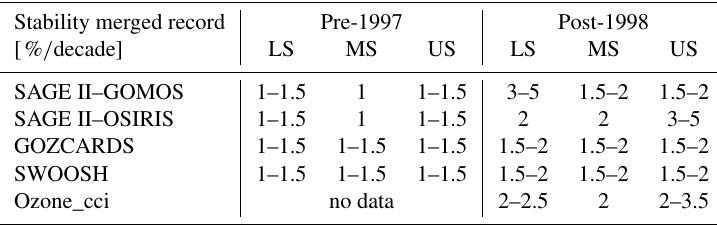
Table 6. Decadal stability of merged ozone profile records (Level-3) estimated from our ground-based assessment of the stability of the contributing Level-2 records, in two time periods and three layers of the stratosphere. These drift values could serve as 1 σ systematic uncertainty in trend studies. Nevertheless, in expectation of more rigourous analyses, the estimates below should be considered with care, as they may overestimate the actual